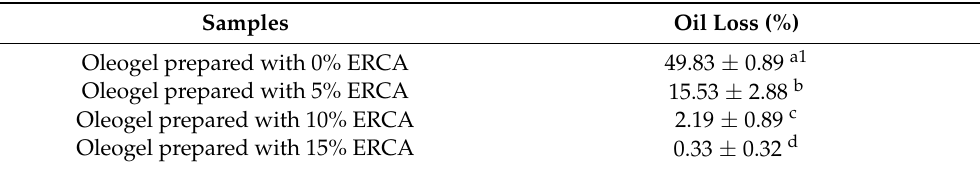
Table 2. Oil loss of oleogels prepared with different concentrations of esterified rice flour with citric acid